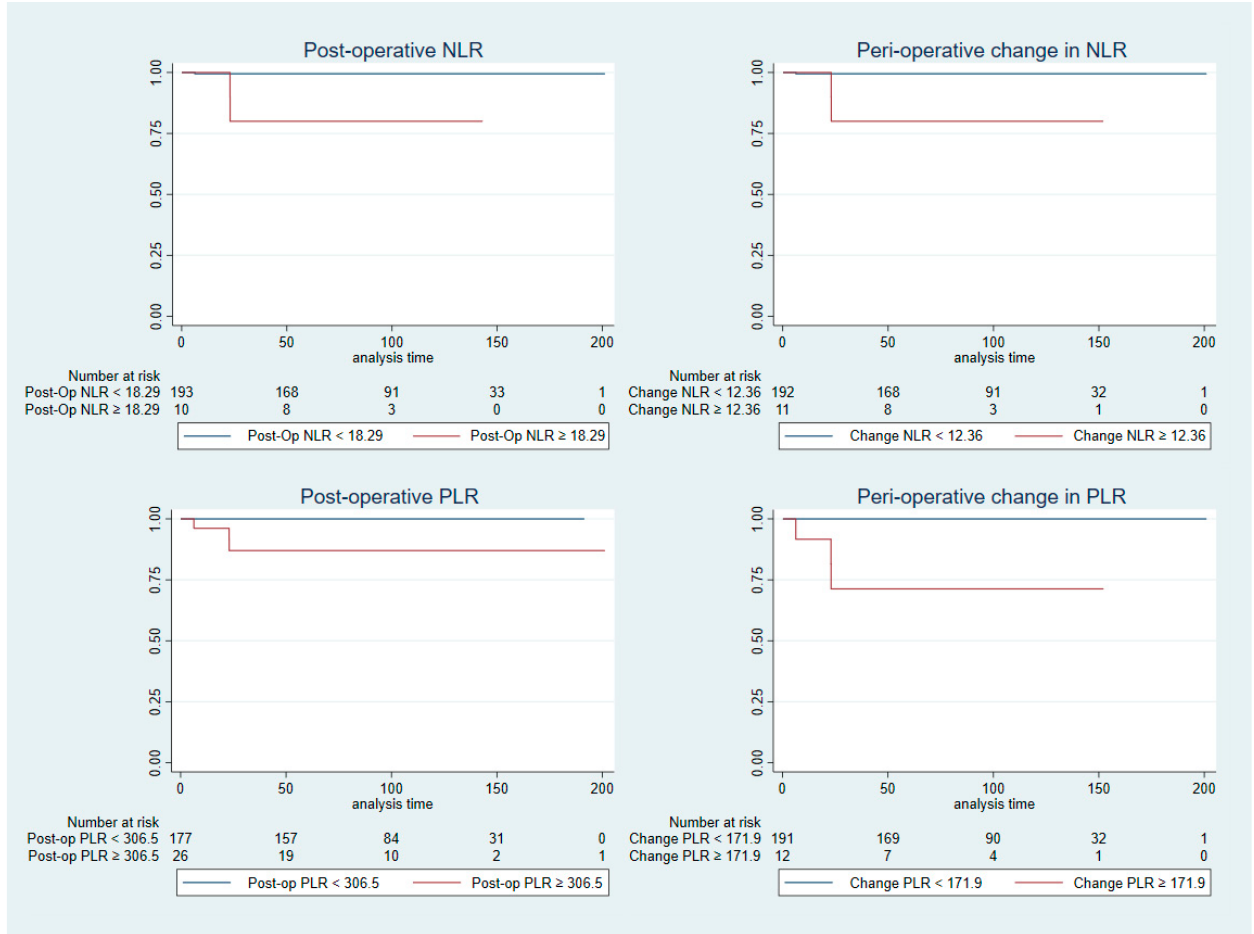
Figure 2. Kaplan–Meier graphs outlining the association between cancer-specific survival with PLR and NLR. Table 4. Multivariable analysis of NLR and PLR for cancer-specific